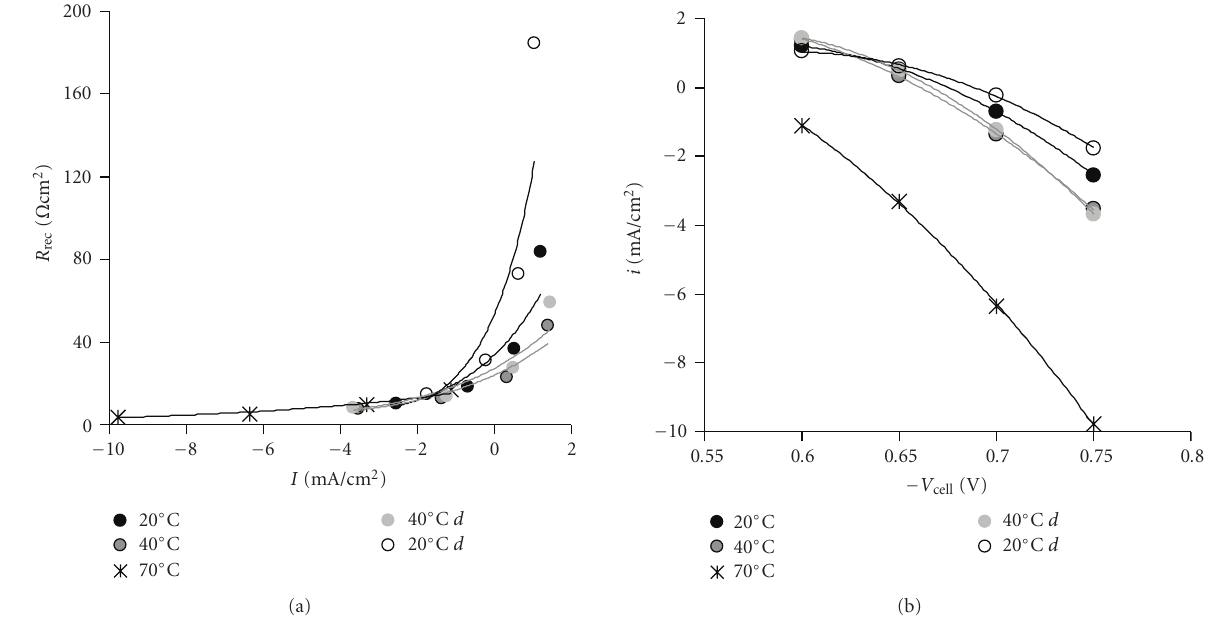
Figure 7: Recombination resistance as a function of current density (a) and current density as a function of cell voltage (b), at di ff erent temperatures; second set of EIS measurements. Letter “ d ” after the temperature value indicates the downward sweep of the temperature cycle.